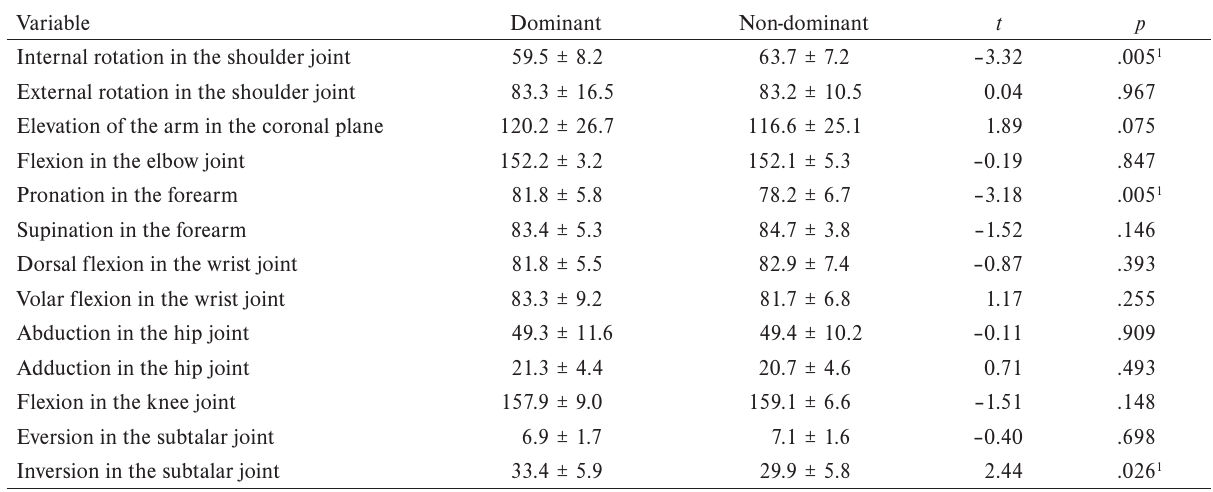
Table 1 Differences in range of motion between the dominant and non-dominant joint before match play. Values are presented in degrees as mean ± SD.